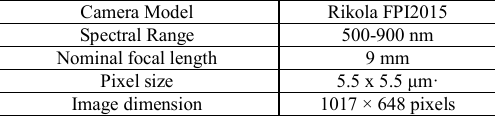
Table 1. Technical data of the Rikola camera.